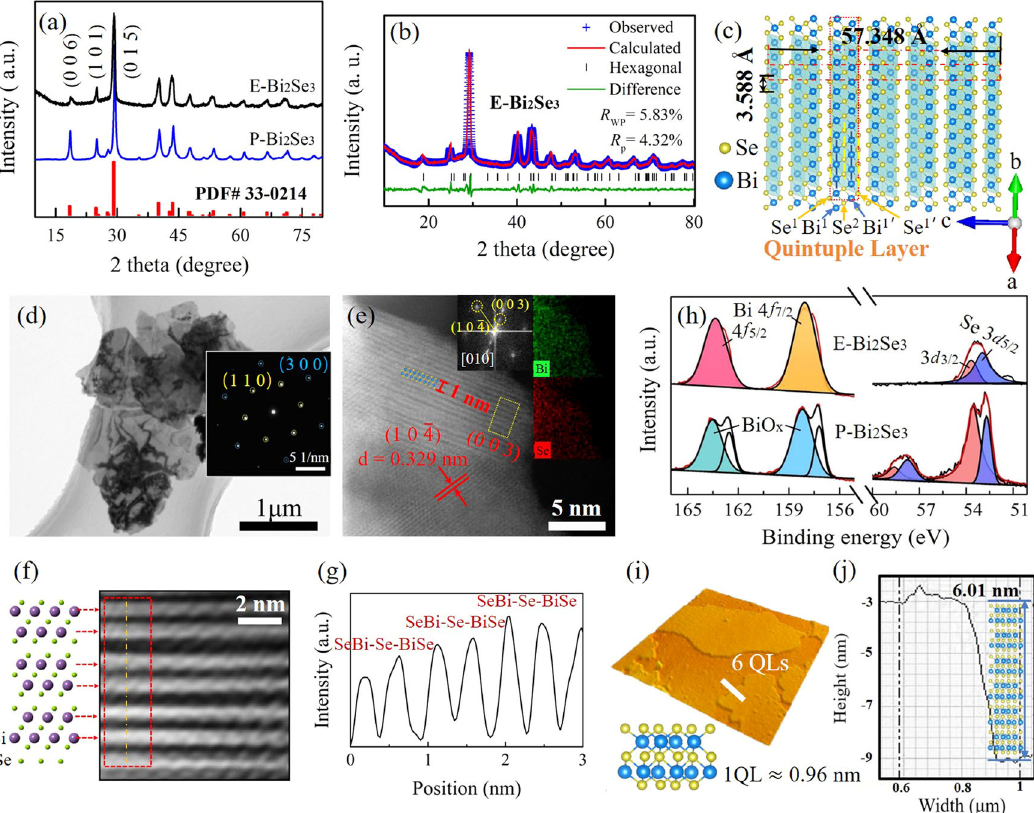
Fig. 1 Structural and morphological characterization of prepared P-Bi 2 Se 3 and E-Bi 2 Se 3 . a XRD analyses of P-Bi 2 Se 3 and E-Bi 2 Se 3 (matched with powder diffraction fi le cards No. 00-033-0214). b Rietveld re fi nement of the XRD pattern of E-Bi 2 Se 3 with reliability factors R wp and R p of 5.83% and 4.32%, respectively. c Layered crystal structure of E-Bi 2 Se 3 with quintuple layers aligned perpendicular to the trigonal c-axis. The dashed red square indicates a quintuple layer in the Se 1 -Bi 1 -Se 2 -Bi 1 0 -Se 1 0 sequence, and the dimensions shown here are calculated from the lattice constants. d TEM image of E-Bi 2 Se 3 and corresponding SAED pattern. e HAADF- STEM image of E-Bi 2 Se 3 and its corresponding EELS elemental mappings along [010] zone axis. f A magni fi ed view of the yellow rectangular area in e with the E-Bi 2 Se 3 crystal structure. g An intensity pro fi le from orange line in f . h XPS spectra of Bi 4 f and Se 3 d signals for P-Bi 2 Se 3 and E-Bi 2 Se 3 . i Typical AFM image of individual E-Bi 2 Se 3 and j corresponding height pro fi are observed due to the Se-Bi-Se atoms column. We averaged several plots across Se-Bi-Se cluster along pink dashed lines (Supplementary Fig. 5e). Assume the atom is a Gaussian shape. The averaged plot (average of 8 line pro fi les) is fi tted with Gaussians (Supplementary Fig. 5f). Two Se atoms do not dis- tribute symmetrically around Bi site. The phenomena are due to that the atomic con fi guration at different areas may have certain distortion after HEMM and hydrothermal exfoliating processes as capturing the atomic-scaled HAADF image along [010] zone axis (see Supplementary Fig. 5 for details). Two peaks together in Fig. 1g corresponds to a QL of Se-Bi-Se-Bi-Se with a thickness approaching 1 nm, con fi rming the ordered arrangement of QLs originating from the layered structure. High-resolution HAADF- STEM image from the B region of Supplementary Fig. 5a shown in Supplementary Fig. 5g has a (003) crystal plane orientation con fi rmed by corresponding Fourier transform (FT) pattern, which highlights the lamellar structure of E-Bi 2 Se 3 (Supplemen- tary Fig. 5h). The electron energy loss spectrum of E-Bi 2 Se 3 shows that E-Bi 2 Se 3 does not contain Li as there is no peak at 55 eV in Supplementary Fig. 5i. X-ray photoelectron spectroscopy (XPS) also indicate the composition of P-Bi 2 Se 3 and E-Bi 2 Se 3 (Supple- mentary Fig. 6a). No liquid intercalation was observed (Supple- mentary Fig. 6b). The high-resolution spectra reveal the valence states of the Bi and Se (Fig. 1h). The Bi 4 f spectrum of E-Bi 2 Se 3 has two peaks at 163.37 and 158.02 eV, corresponding to the Bi 4 f 5/2 and 4 f 7/2 binding energies attributable to Bi 2 Se 3 , respectively,